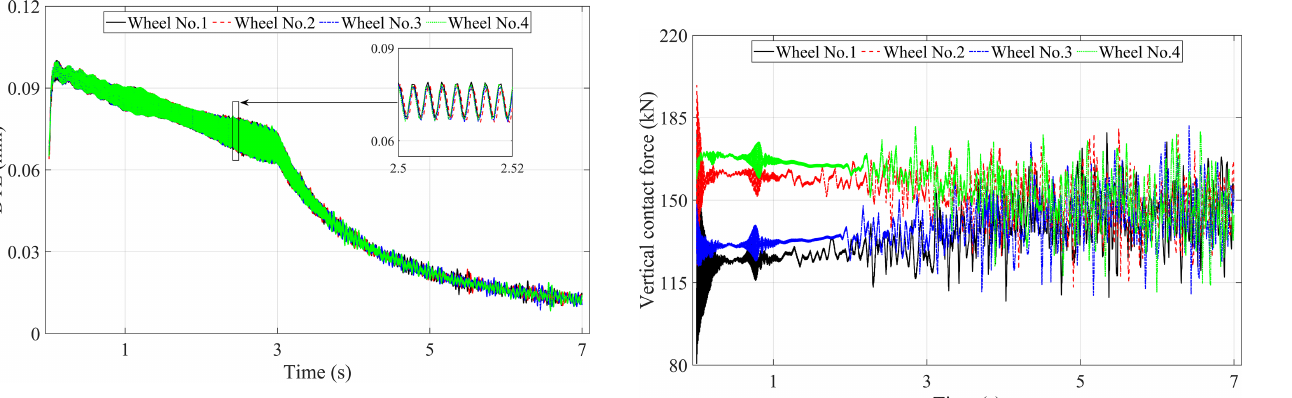
Figure 12. DTEs of the gear pairs under traction condition.